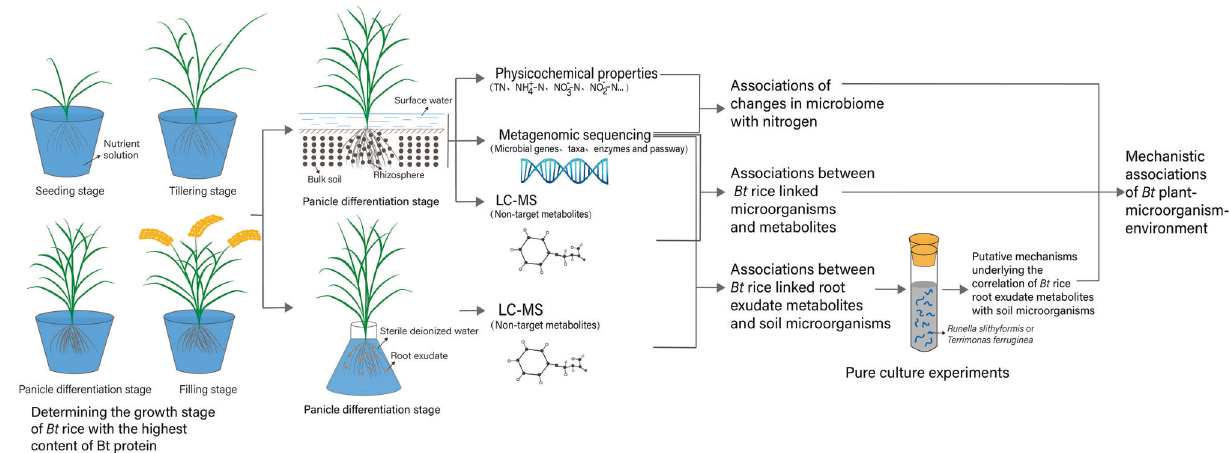
Fig. 1 Flow chart of experimental